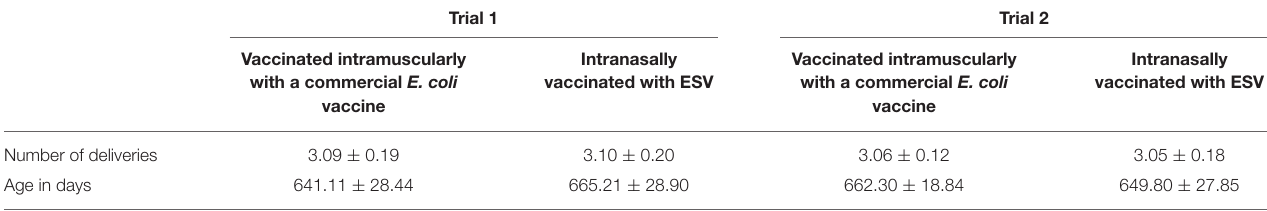
TABLE 1 | Number of deliveries and age of the pregnant sows selected for the evaluation of the induction of secretory IgA in colostrum and serum IgG in Experiment 1. Trial 1 Trial 2 Vaccinated intramuscularly Intranasally Vaccinated intramuscularly Intranasally with a commercial E. coli vaccinated with ESV with a commercial E. coli vaccinated with ESV vaccine vaccine Number of